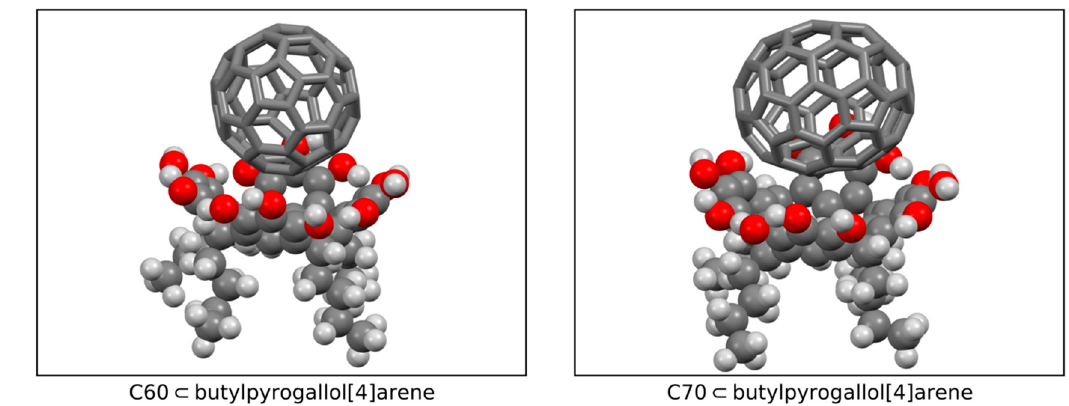
Figure 6. Illustration of the calculated binding modes of C 60 ⊂ butylpyrogallol[4]arene and C 70 ⊂ butylpyrogallol[4]arene. The red, light grey and dark grey spheres represent oxygen, hydrogen, and carbon atoms, respectively.